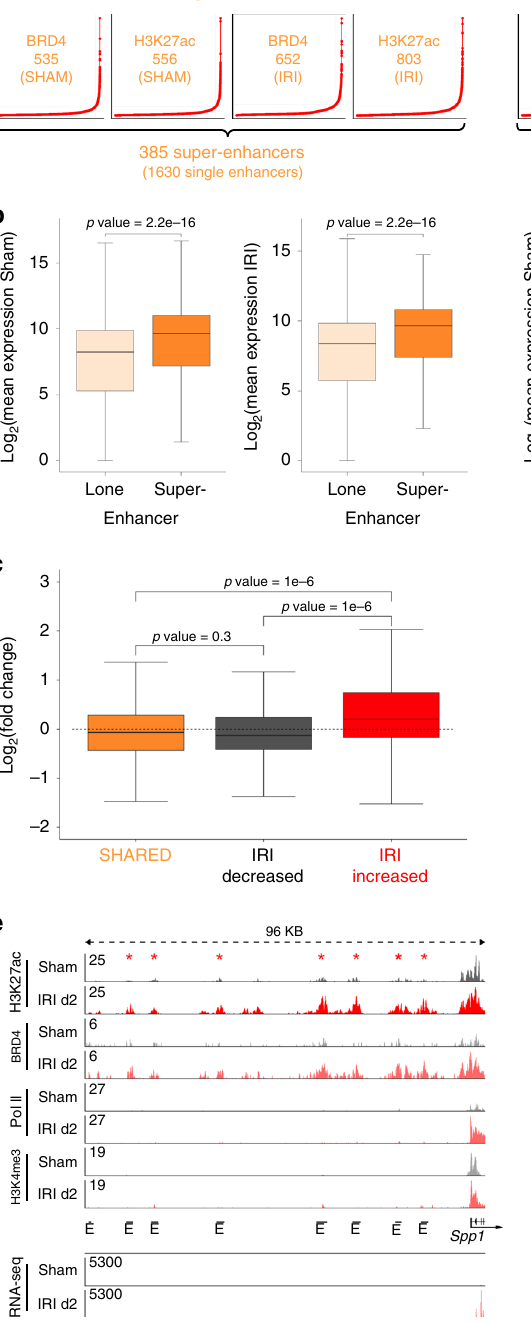
(Supplementary Data 6 – 8), re fl ecting super-enhancer association to high abundant gene expression and the important role of super-enhancers in kidney epithelial